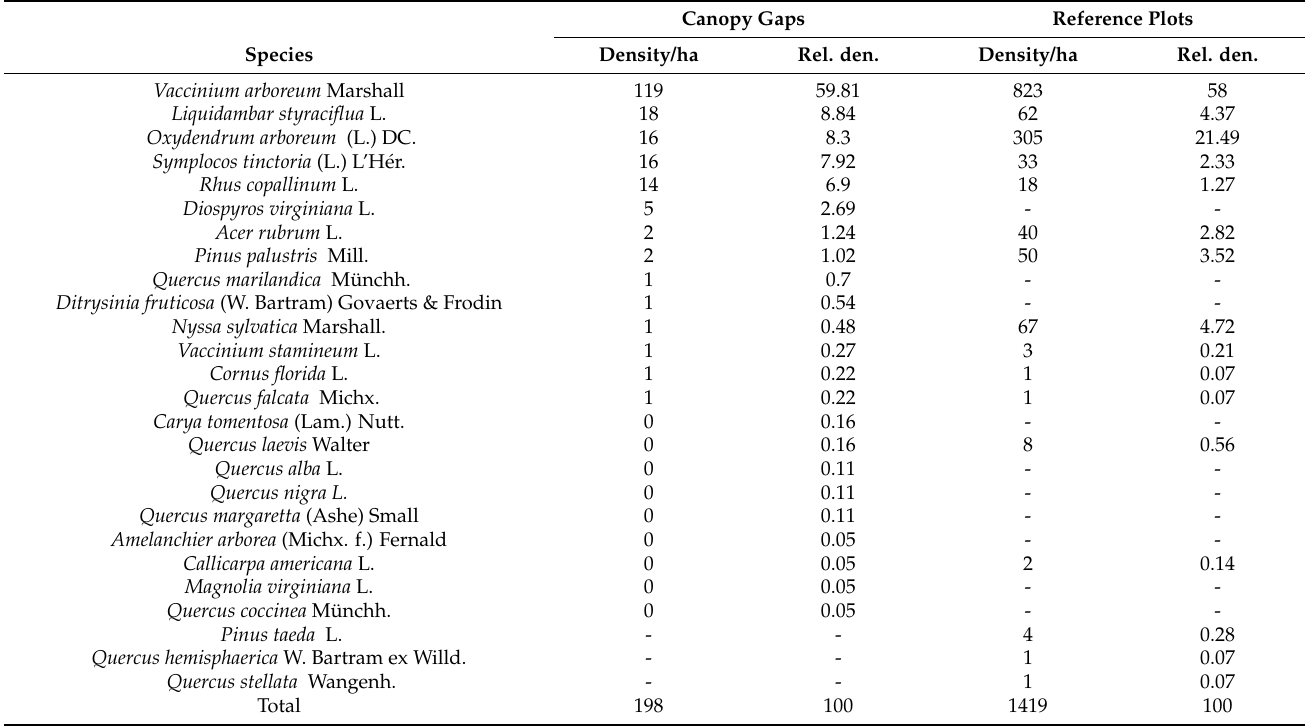
Table 2. Density and relative density for saplings (stems ≥ 1 m tall, <10 cm dbh) in canopy gap and reference (non-gap) plots in a montane Pinus palustris woodland.